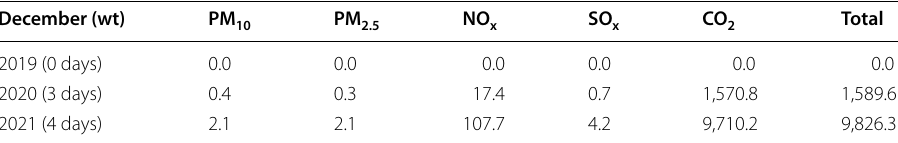
Table 5 Total air emissions of anchored ships and ships outside SAQA from 2019 to 2021 in the average waiting time (wt) in December (in tons) December (wt) PM 10